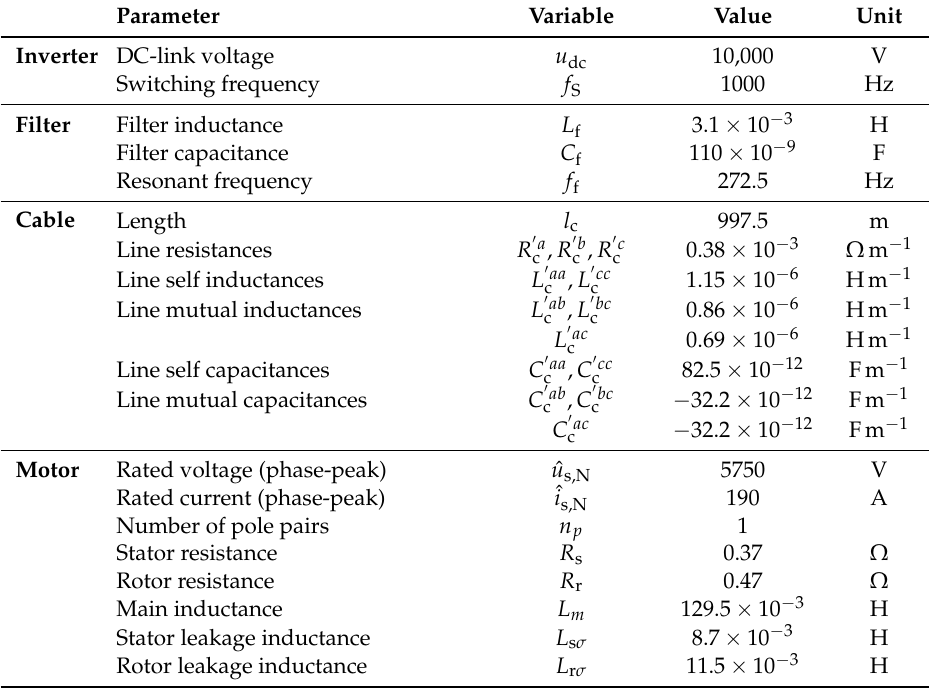
Table 2. Simulation parameters of the electrical subsystem.